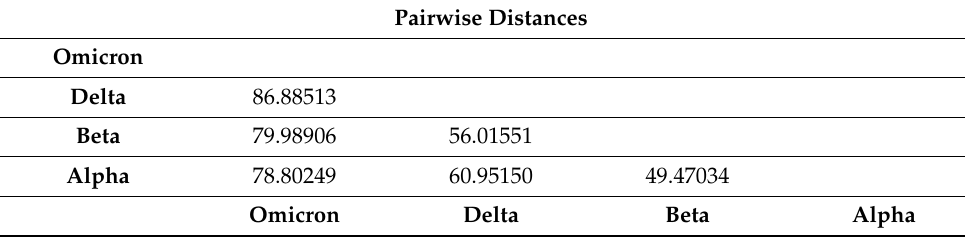
Table 3. Pairwise distances between variants (mean number of differing bases for all sequences). Calculated from the GISAID data using the MEGA software [32]. Number of sequences: Omicron- 8457, Delta-10000, Beta-4237,